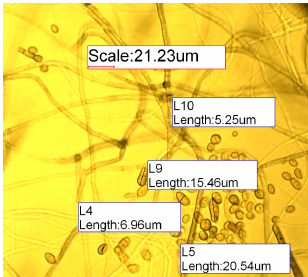
Figure 1. Plasmopara viticola (microscope view)—sporangiophores and sporangia. Identification according to